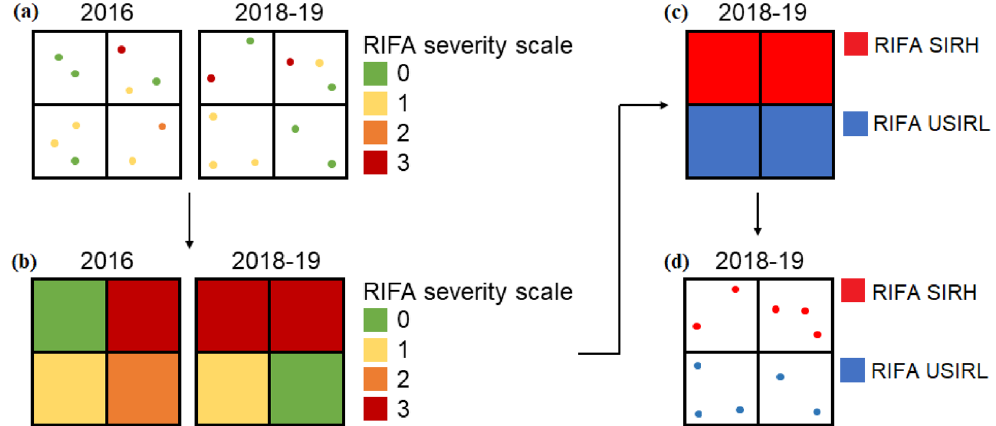
Figure 2. Quantification of RIFA successful invasion or remaining at the highest level of invasion (RIFA SIRH) and RIFA unsuccessful invasion or remaining at low levels of invasion (RIFA USIRL),